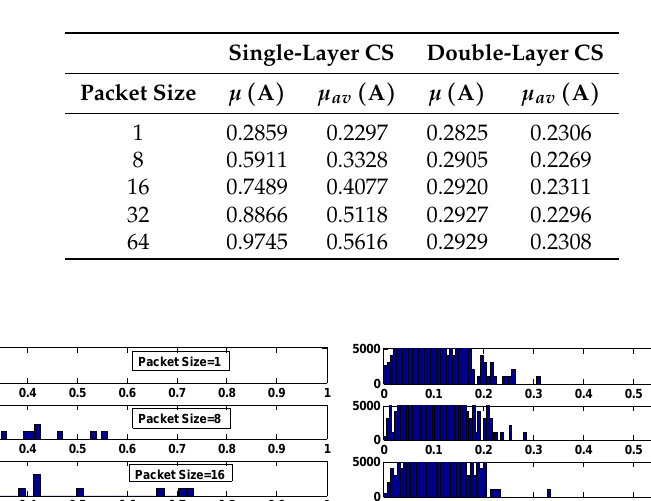
Table 2. The mutual coherence of the equivalent measurement matrix under the single-layer CS and double-layer CS framework when N = 512 and M = 64.